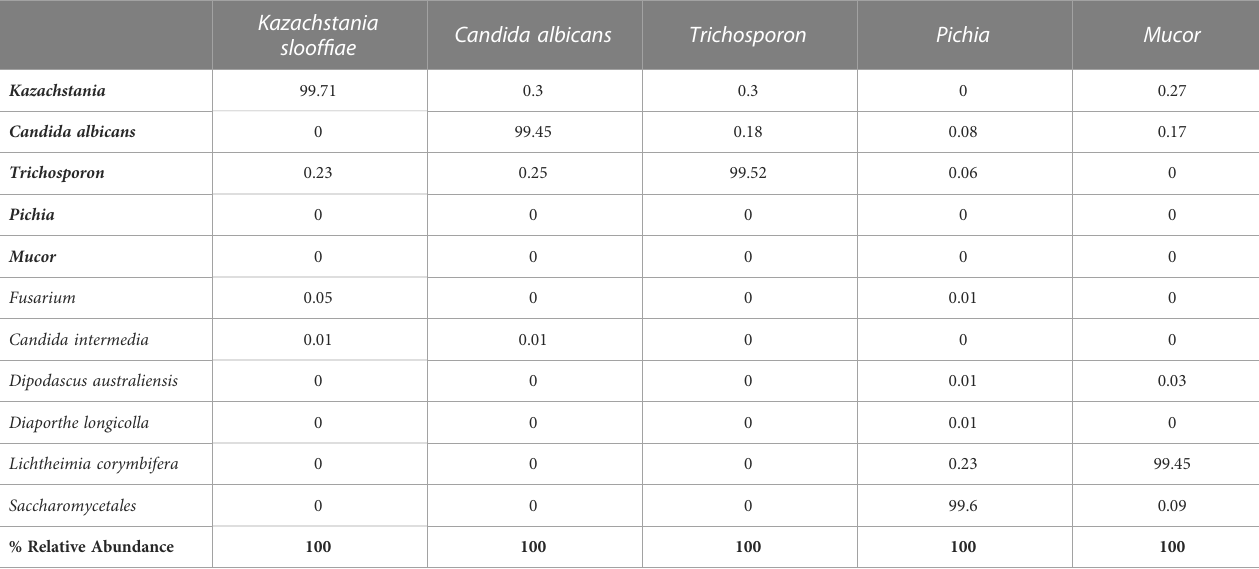
TABLE 5 Single species sequencing